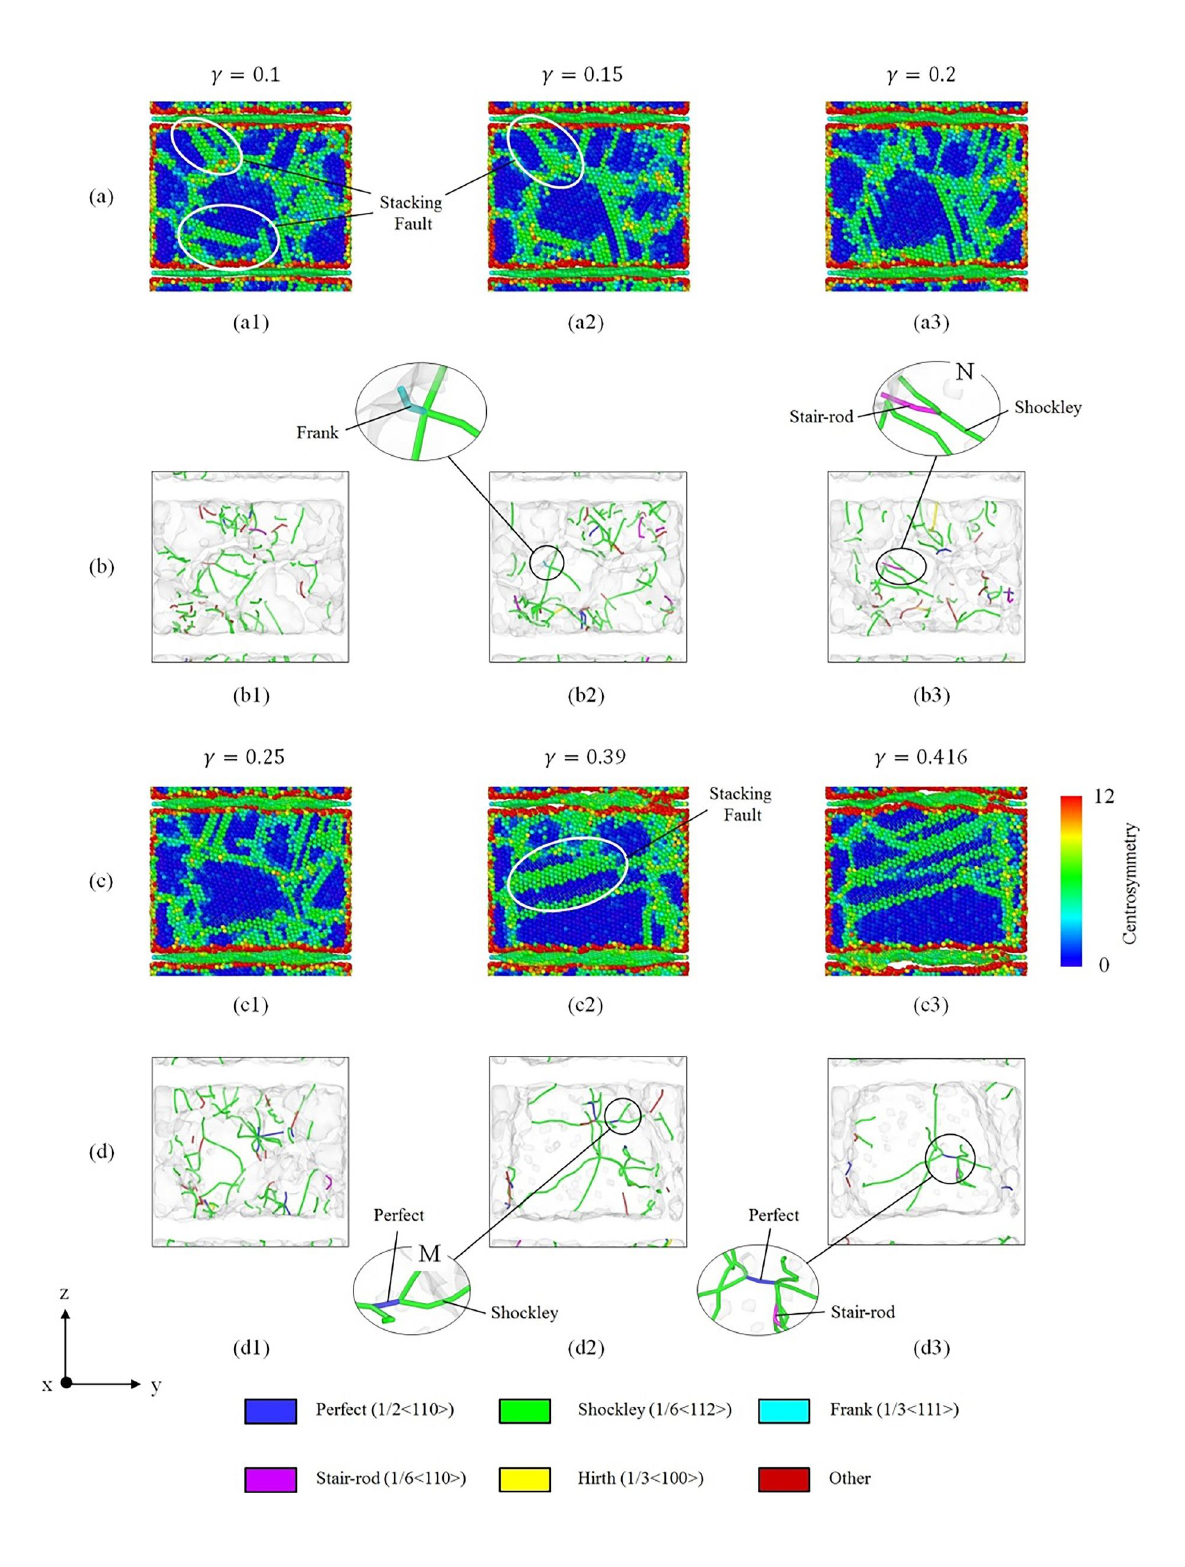
Figure 5: (a, c) Cross-sectional view of the CSP analysis of the GPCuNL composites and (b, d) DXA analysis of the dislocation evolution of the GPCuNL composites along the zigzag direction at 300